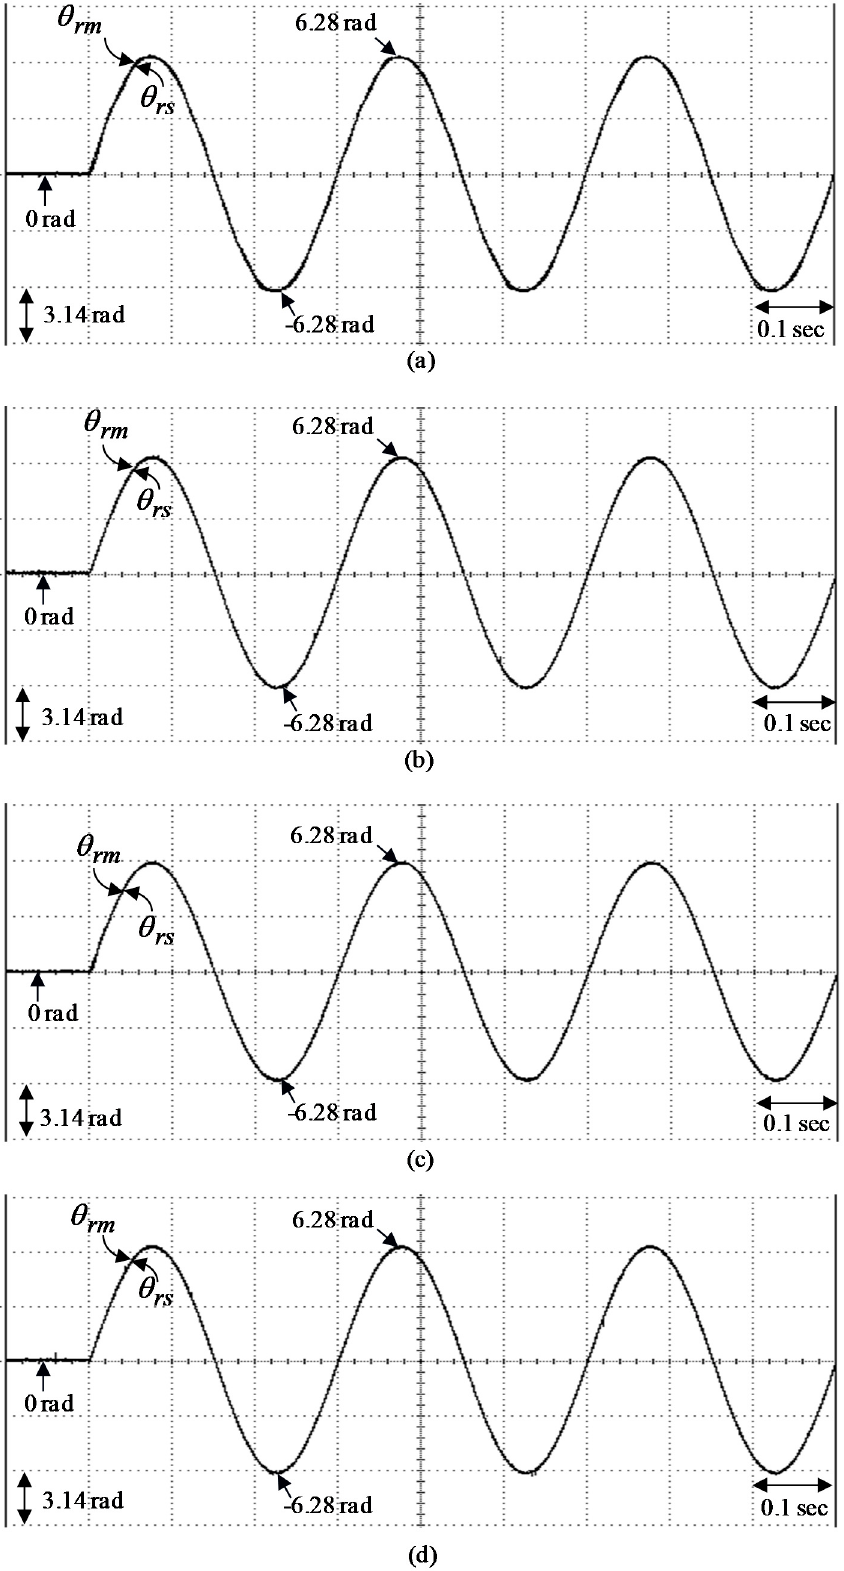
Figure 12. Experimental results of the rotor position response in Case R3 ( a ) by utilizing control system W1, ( b ) W2, ( c ) W3, and ( d ) W4.